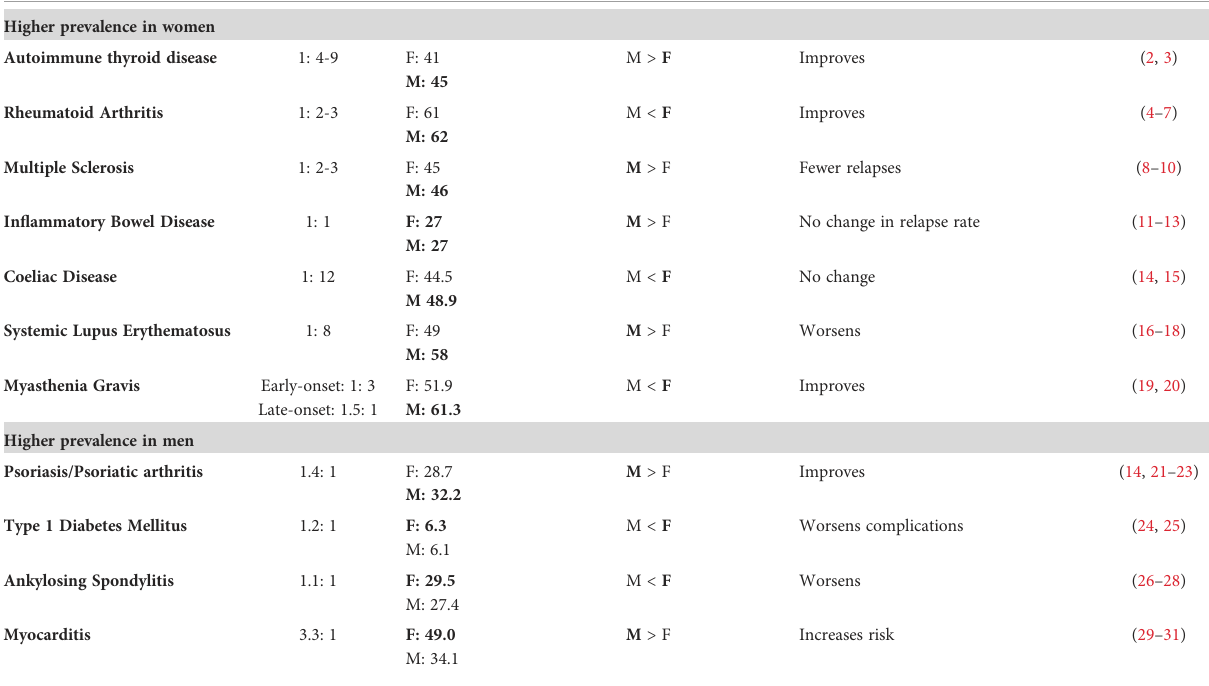
TABLE 1 Sex bias in autoimmune diseases. Disease Male: Female Average age of onset Disease